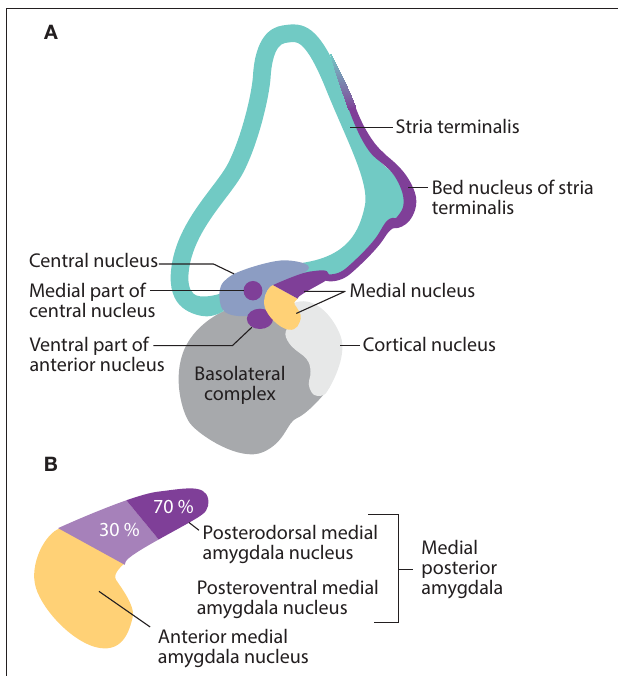
FIGURE 4 | Nkx2-1 expression in mature amygdala nuclei, and the stria terminalis in the rodent brain is restricted to subnuclei involved in social, reproductive, and fear-defense responses. (A) Expression occurs in the posterodorsal and posteroventral medial nuclei, the ventral part of the anterior nucleus, the medial part of the central nucleus, the medial extended amygdala, and the posteromedial bed nucleus of the stria terminalis. (B) Details of the medial amygdala nucleus. Nkx2-1 is expressed by 70% of neurons in the posterodorsal medial nuclei (social-reproductive) and 30% of neurons in the posteroventral medial nuclei (fear-defense), suggesting different roles for NKX2-1 in the two sets of